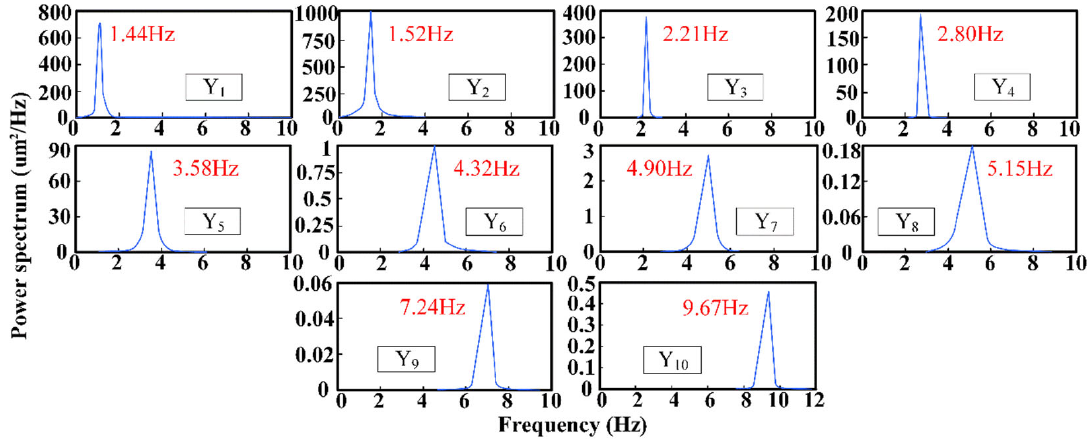
Figure 10. Power spectral of Y 1 ~Y 10 components.